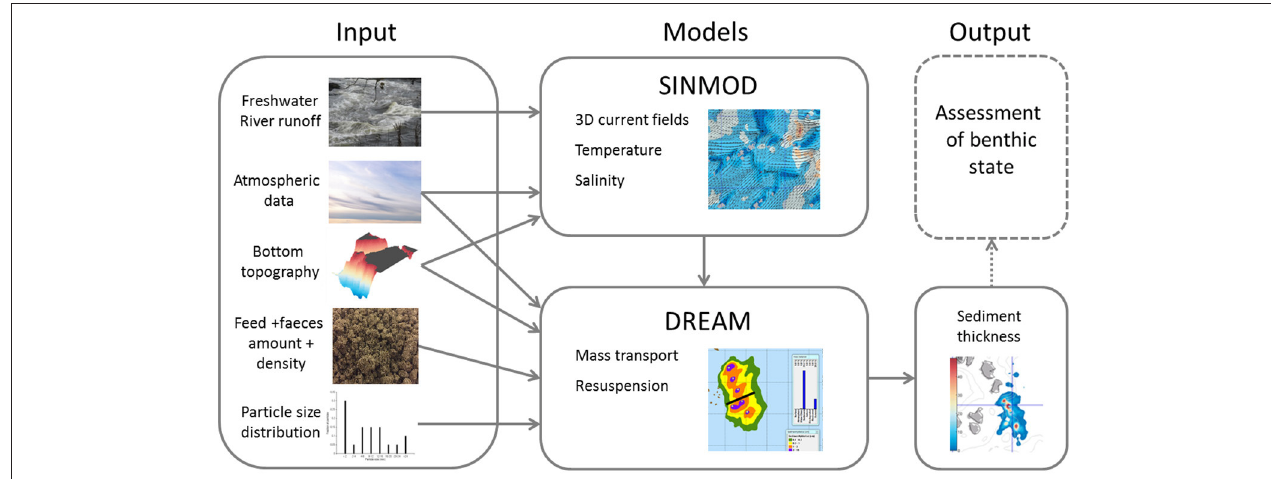
FIGURE 1 | Schematic for the coupling of the model systems SINMOD and DREAM, the input data used and the output. The model system provides explicit information on the mud thickness. The ultimate assessment of benthic state has to be made based on the simulation results (dashed